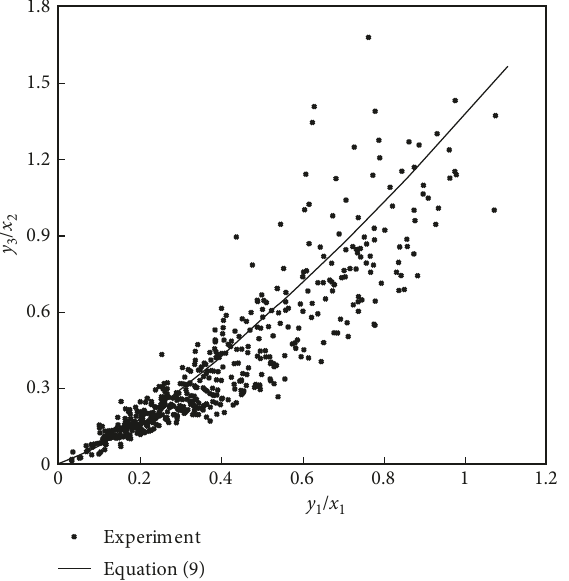
Figure 5: Relationship between y